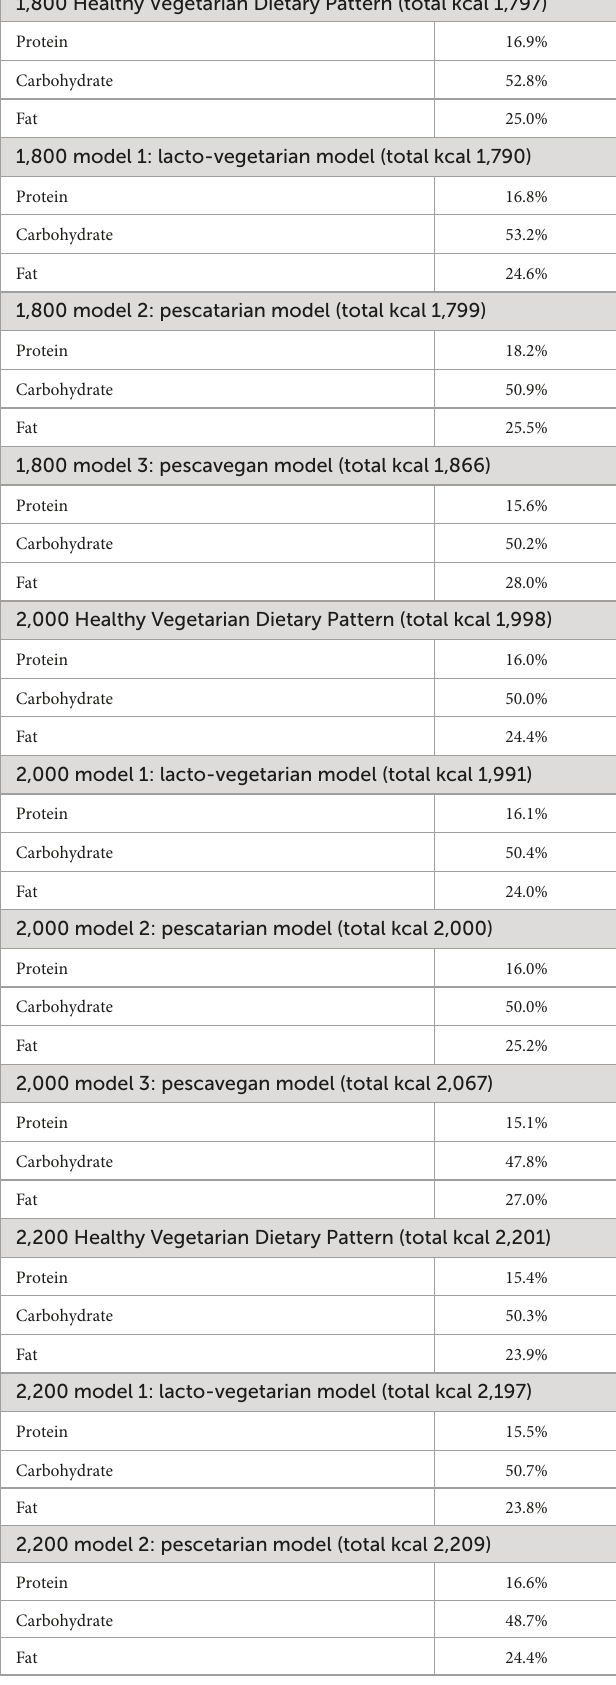
TABLE 3 Acceptable Macronutrient Distribution Ranges in percentage of total calories. 1,800 Healthy Vegetarian Dietary Pattern (total kcal